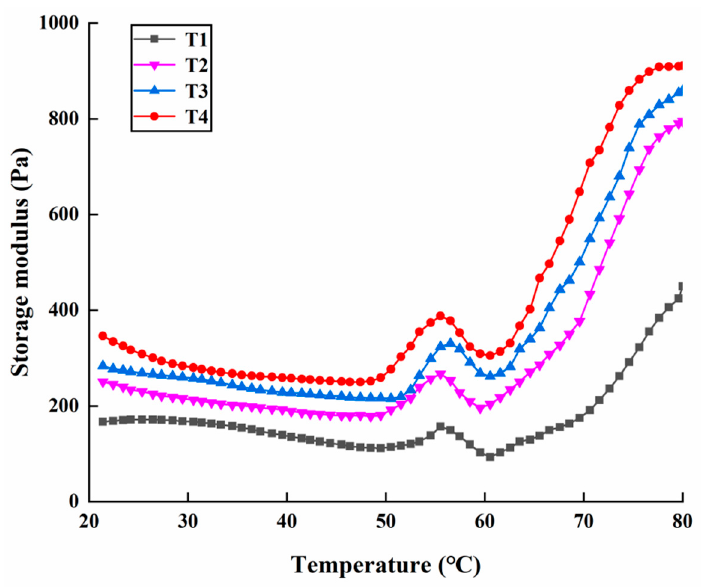
Figure 3. The changes in G ′ values of the PSE meat myofibrillar protein gels with varying amounts of added sodium bicarbonate. T1, 0/100 g sodium bicarbonate; T2, 0.2/100 g sodium bicarbonate; T3, 0.4/100 g sodium bicarbonate; T4, 0.6/100 g sodium bicarbonate.